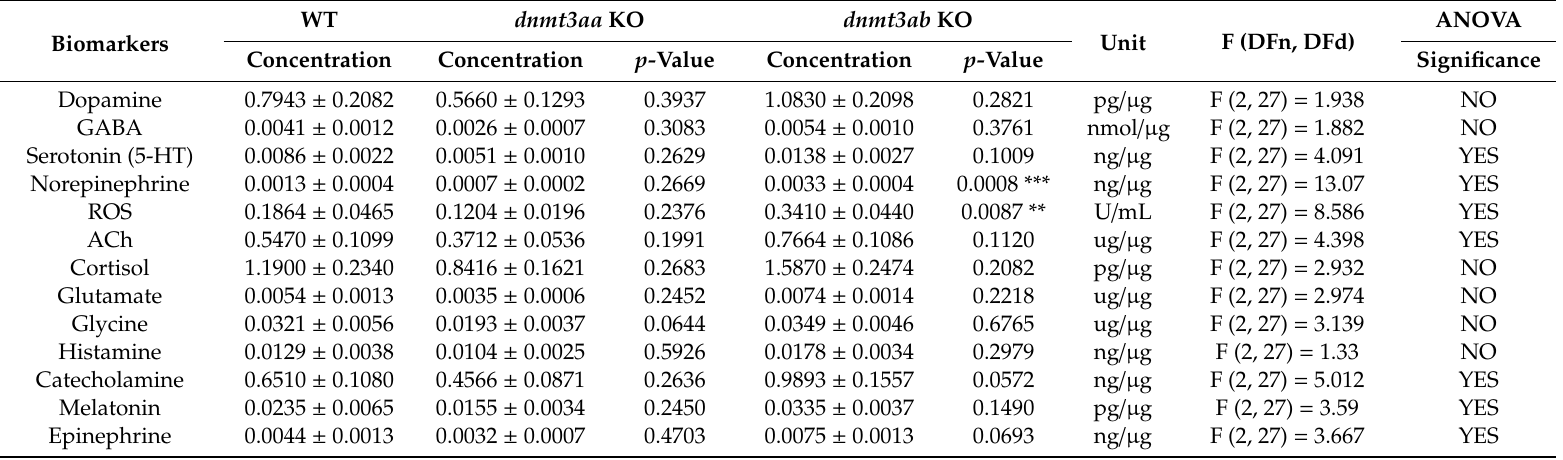
Table 2. Comparison of neurotransmitter and other biomarker levels in the body of wild type (WT), dnmt3aa KO, and dnmt3ab KO zebrafish. The data are expressed as the mean with S.E.M. and analyzed by one-way ANOVA followed by Fisher’s LSD post hoc test ( n = 10 for all groups, ** p < 0.01, *** p <